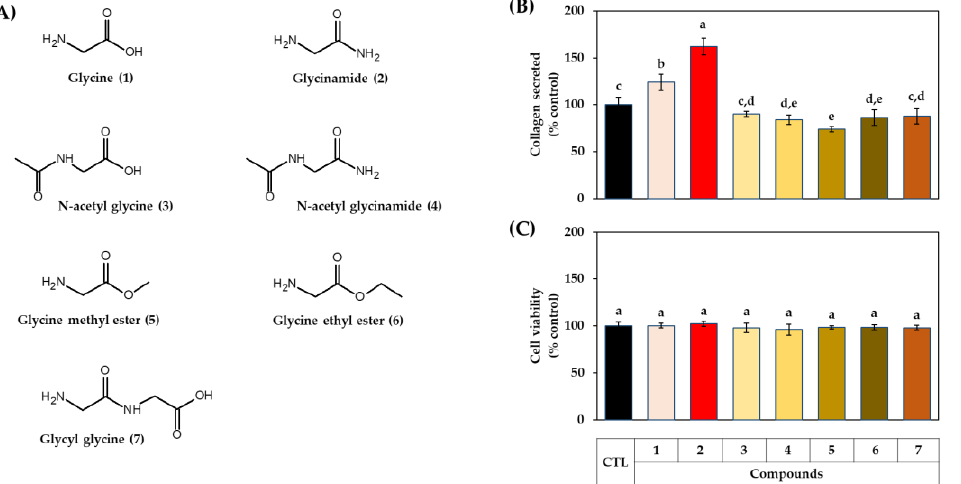
Figure 3. Effects of glycine analogs on collagen production and the viability of HDFs. Chemical structures of glycine (1), glycinamide (2), N-acetyl glycine (3), N-acetyl glycinamide (4), glycine methyl ester (5), glycine ethyl ester (6), and glycyl glycine (7) are shown ( A ). Cells were treated with vehicle (CTL) or each compound at 1 mM. After 48 h, the collagen protein secreted into the conditioned medium was quantitated ( B ). The viability of the adherent cells was determined ( C ). Data are presented as % of control (means ± SD, n = 3 for ( A ), and n = 4 for ( B )). Groups that share the same alphabet letters (a–e) do not have significantly different means at the p < 0.05